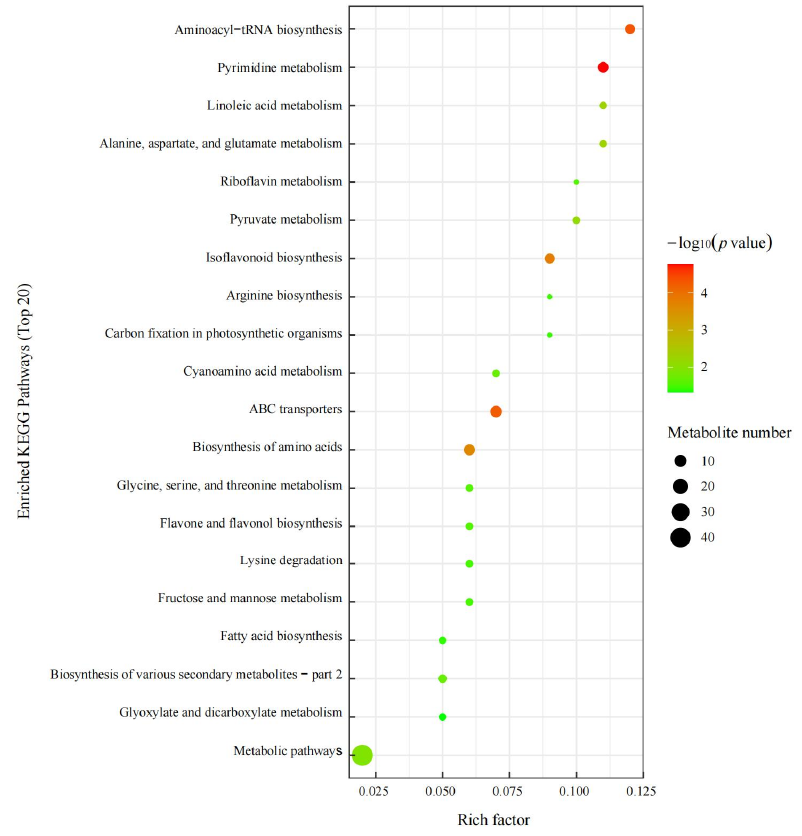
Figure 5. Bubble diagram of the pathways with differential metabolite enrichment. As shown in the bubble diagram, each bubble represents a metabolic pathway (the top 20 metabolic pathways with the highest abundance were selected based on the p value). The abscissa and bubble size represent the extent of the pathway’s influence. The larger the bubble is, the greater the influence. In enrichment analysis, the ordinate and color of bubbles represent the p value (negative common logarithm, namely, − log 10 p value). The deeper the color is, the smaller the p value, and the more obvious the enrichment degree.